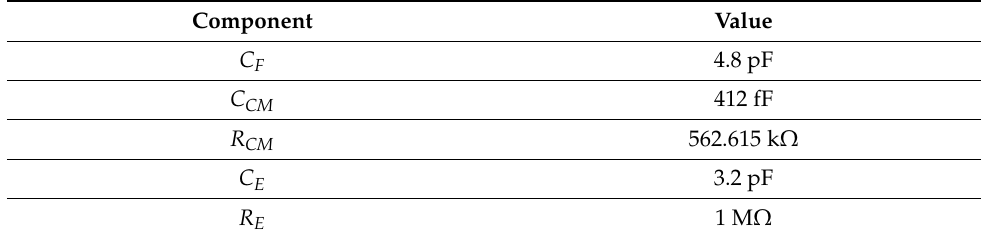
Table 2. Values of passive components in the FDDA.